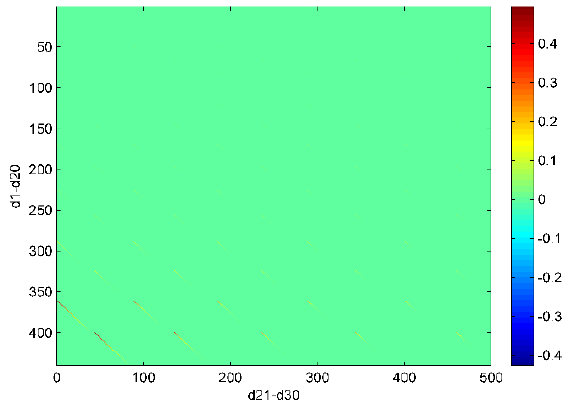
Figure 8. The scaled sensitivity matrix of 5° × 5° grid inversion with a truncation degree of 20. The horizontal axis is arranged in order of ∆ T C